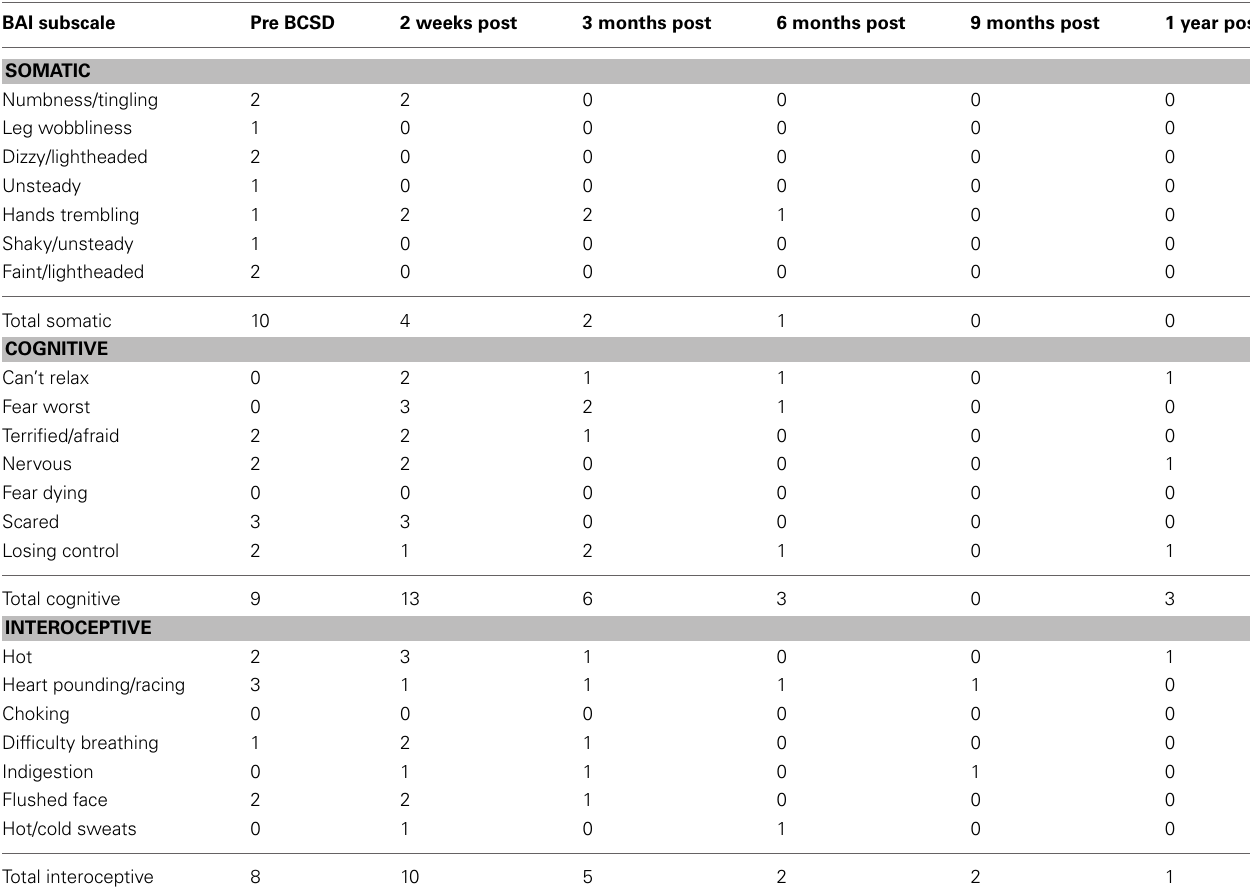
Table 2 | Somatic, cognitive and interoceptive anxiety symptoms in Case 1 during 1 year follow-up, from the Beck Anxiety Inventory (BAI). BAI subscale Pre BCSD 2 weeks